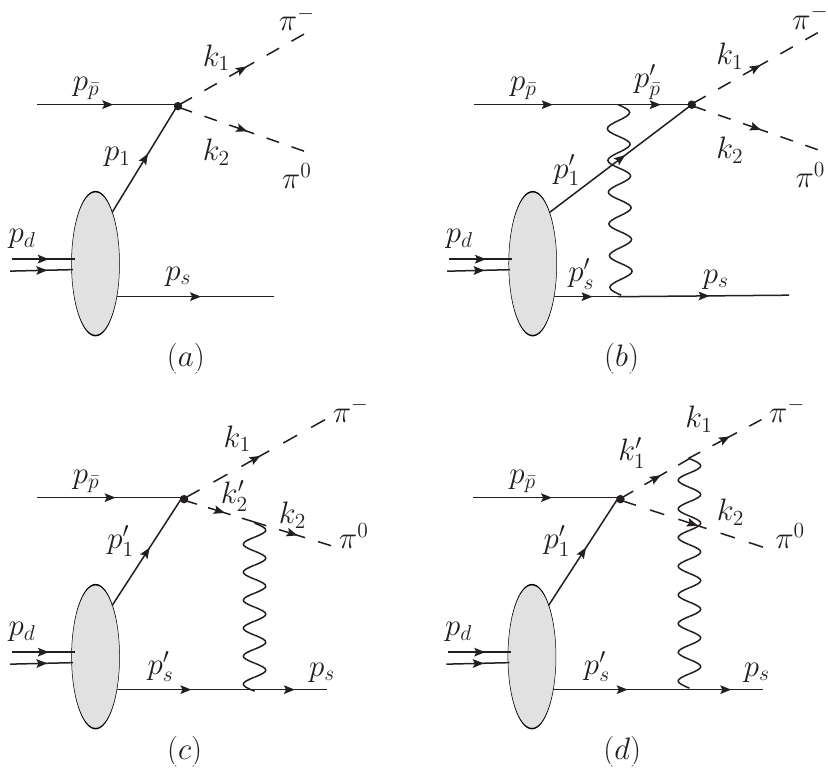
Figure 1. Feynman diagrams for the process ¯ pd π − π 0 p . The wavy lines denote soft elastic → scattering amplitudes. The four-momenta of the antiproton, deuteron, π − , π 0 , and of the spectator proton are denoted as p ¯ p , p d , k 1 , k 2 , and p s , respectively. p 1 is the four-momentum of the intermediate neutron in the impulse approximation (IA) amplitude ( a ). The primed quantities denote the four- momenta of intermediate particles in the amplitudes ( b – d ) with